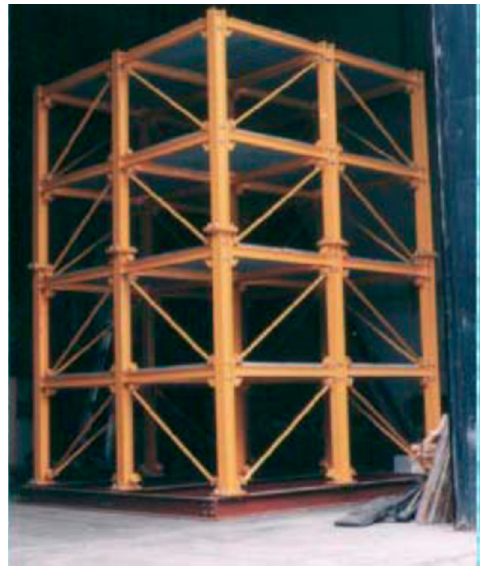
Figure 3. American Society of Civil Engineers (ASCE) structural health monitoring benchmark structure.